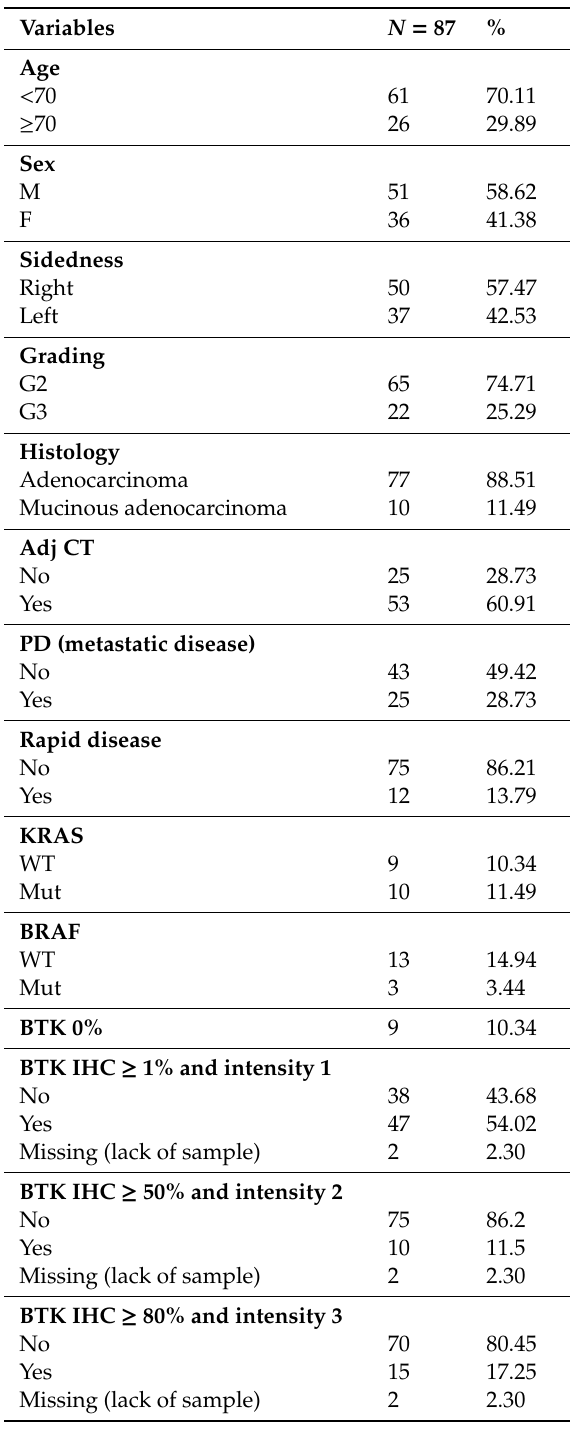
Table 1. Patients’